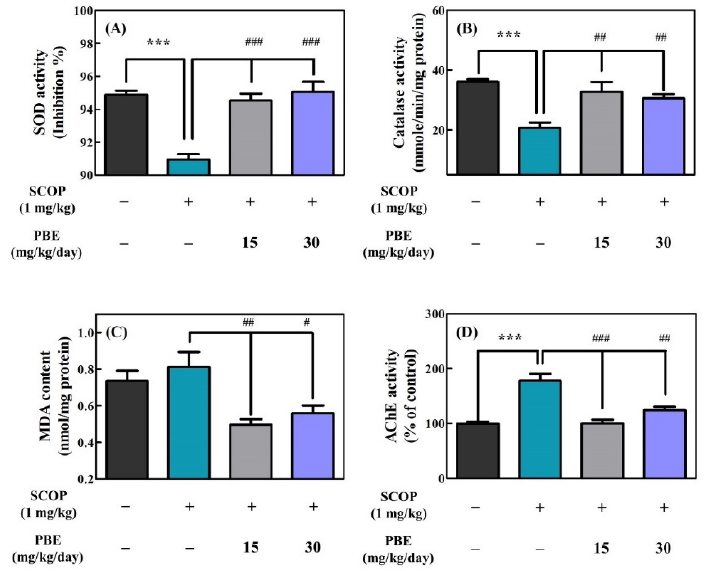
Figure 3. Effects of PBE on ( A ) superoxide dismutase (SOD) activity, ( B ) catalase activity, ( C ) malon- dialdehyde (MDA) content, and ( D ) acetylcholinesterase (AChE) activity in hippocampus lysate of SD rats (n = 8) after the behavioral tests. Tukey’s honestly significant difference test: *** p < 0.001 vs. control and # p < 0.05, ## p < 0.01, ### p < 0.001 vs. SCOP.